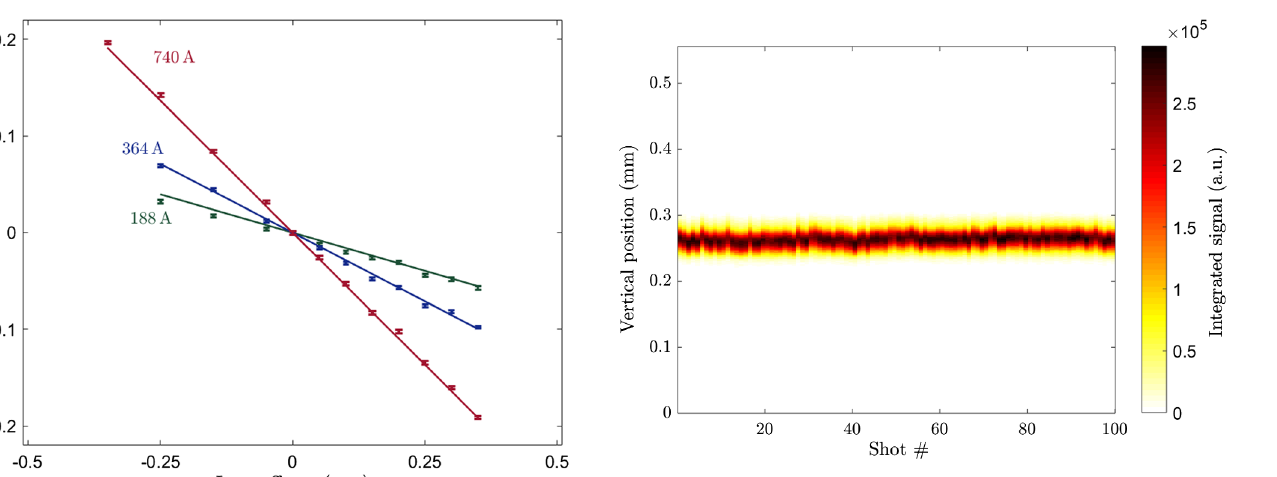
FIG. 4. Camera signal projected onto the vertical axis for 100 consecutive shots at 350 μ m APL offset. The excellent stability of MaMi was not measurably affected by the APL, which is indicated by the small shot-to-shot fluctuations of the signal.